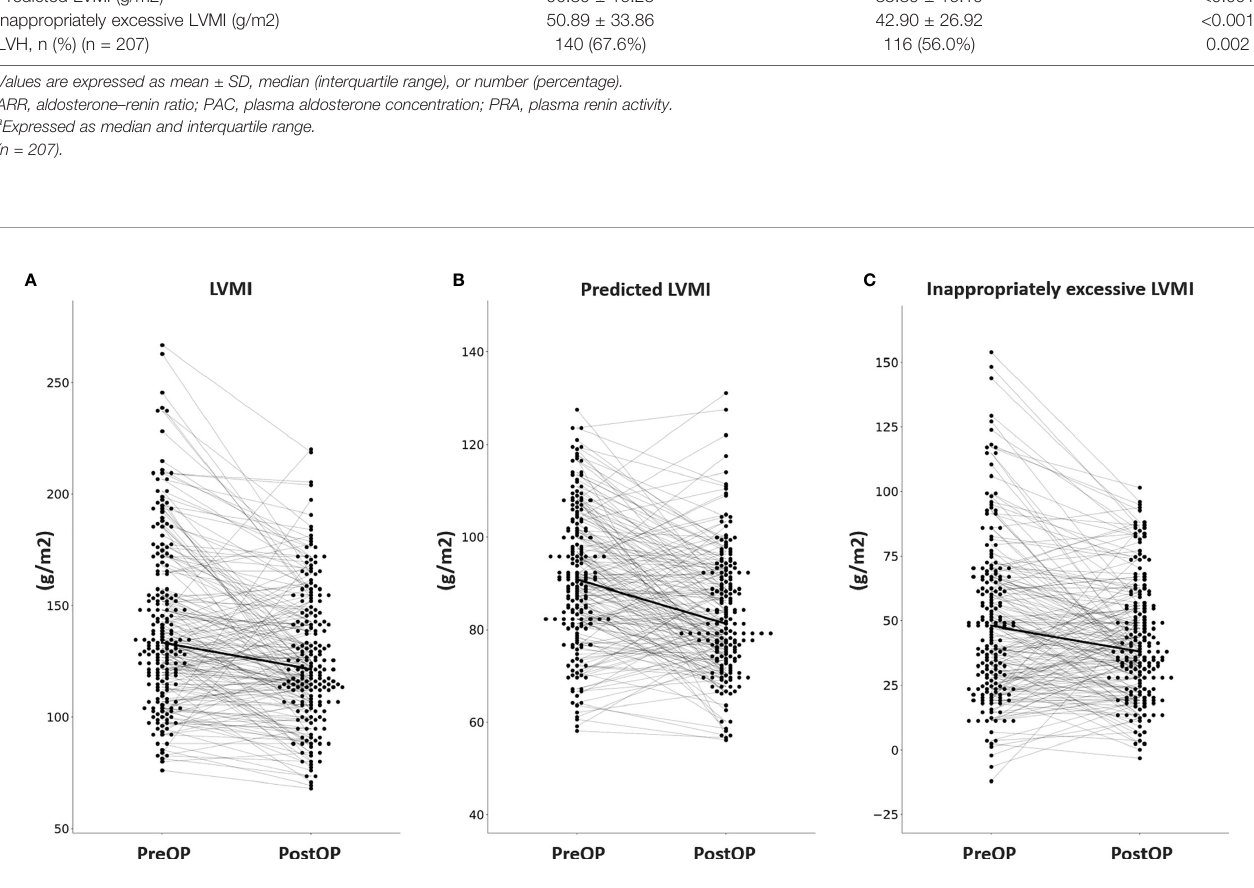
FIGURE 2 | Changes in (A) LVMI, (B) predicted LVMI, (C) and inappropriately excessive LVMI in aldosterone-producing adenoma patients before and after adrenalectomy. LVMI, left ventricular mass index; PreOP, before adrenalectomy; PostOP, after